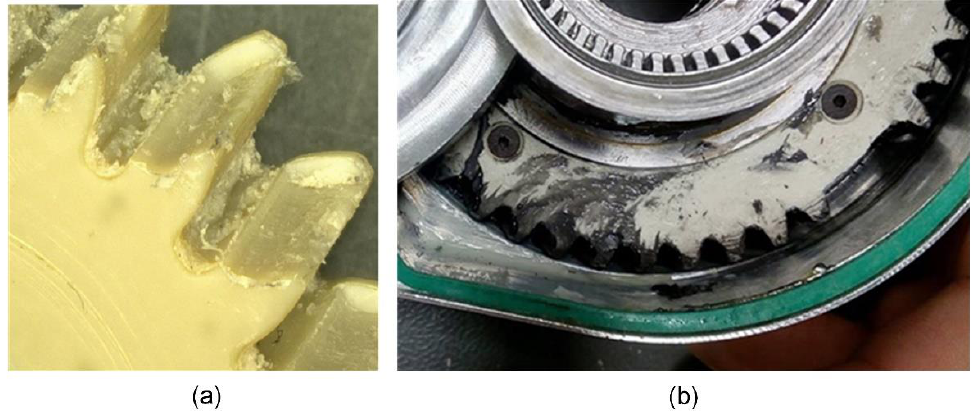
Figure 10. Failure mode of polymer gears: ( a ) wear of PEEK gear paired with steel gear; ( b ) tooth fracture of gear 2 (stage 2).